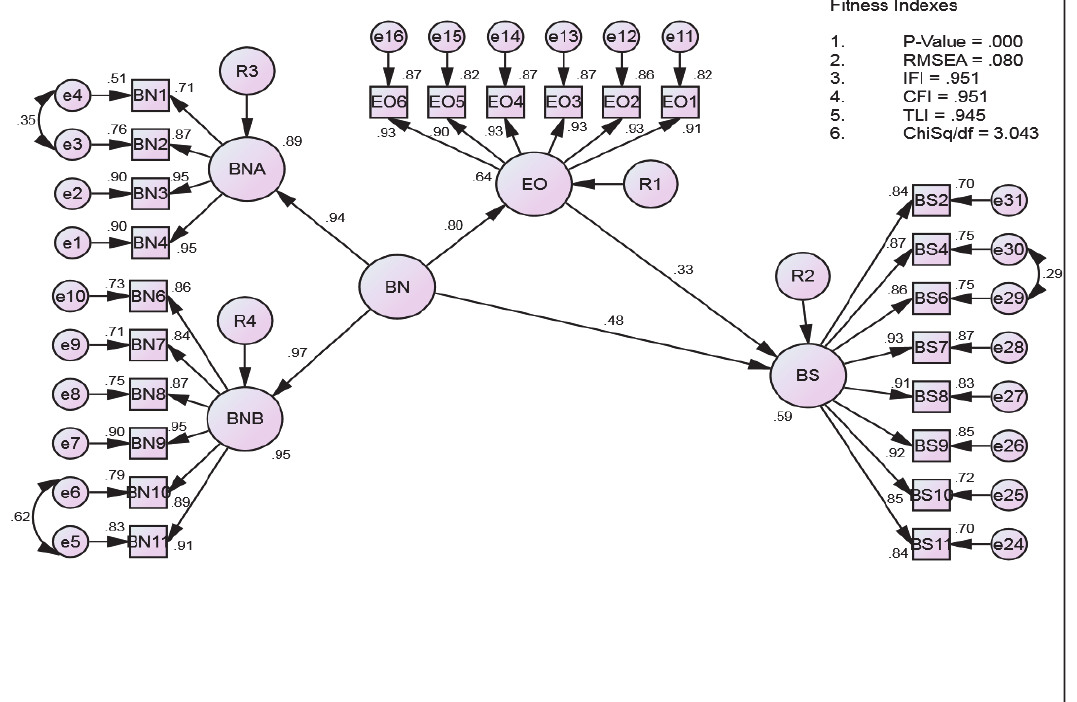
Fig. 3. SEM diagram for the